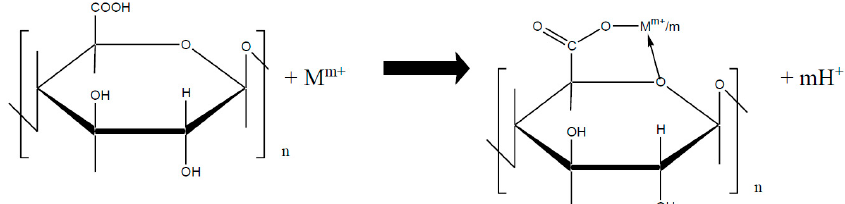
Figure 8. Adsorption of Pb(II), Zn(II) and Cu(II) by DIAION WK11 resin as a function of the